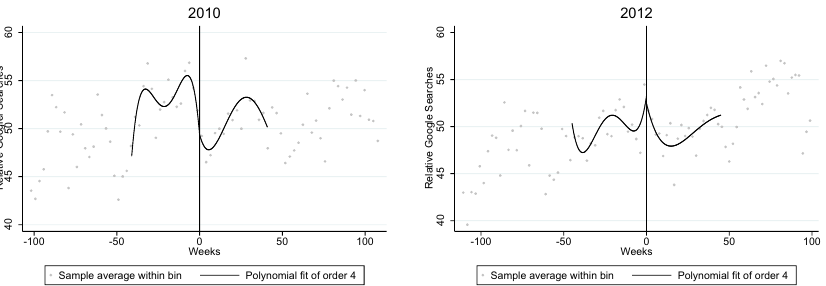
Fig. 4 Regression discontinuity (polynomial order 4): 2012 VAT reform impact on Google searches, by type of